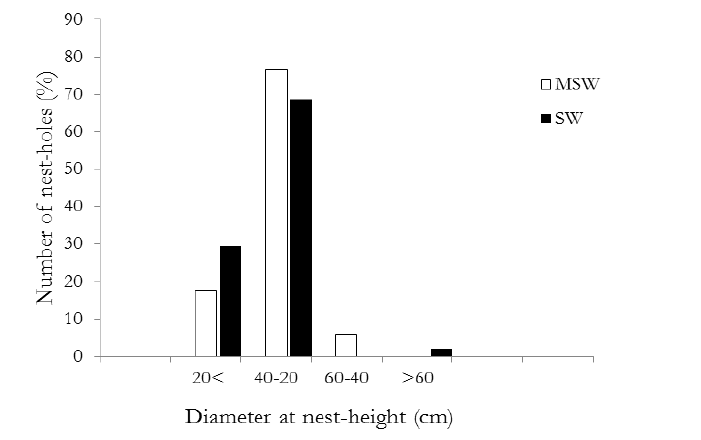
F IGURE 1. Distribution of the diameter at nest-height in Syrian (SW) and Middle